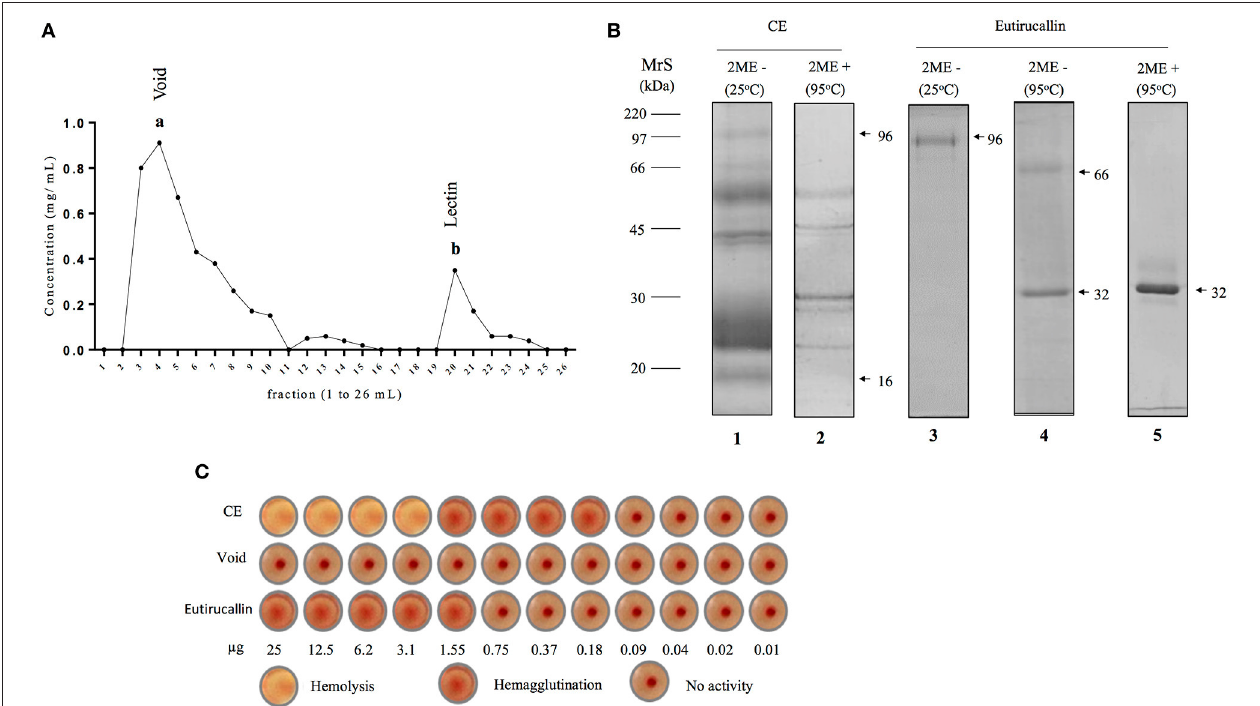
FIGURE 1 | Purification of Eutirucallin from E. tirucalli and its hemagglutinating activity. (A) Eutirucallin purification by galactose affinity chromatography. The first peak (a) corresponds to galactose non-binding proteins (void) and the second peak (b) is related to galactose binding proteins (GBP) eluted with 400 mM of galactose. (B) Electrophoretic profile of crude extract and peak b (Eutirucallin) were analyzed in non-reducing and reducing (2-mercaptoethanol) conditions. MrS: molecular size markers; lane 1, Crude extract at 25 ◦ C and under non-reducing condition; lane 2, crude extract at 95 ◦ C under reducing condition; lane 3, Eutirucallin in non-reducing conditions and incubated at 25 ◦ C; lane 4, Eutirucallin in non-reducing conditions and heated at 95 ◦ C; lane 5, Eutirucallin in reducing conditions. 2ME + and 2ME − correspond, respectively, to the presence and absence of 2-mercaptioethanol. (C) CE (crude extract) showed hemolytic effects (25–3.1 µ g) and hemagglutinating activity (1.55–0.18 µ g). Void did not present any activity. Eutirucallin presented hemagglutinating activity (25–1.55 µ g).